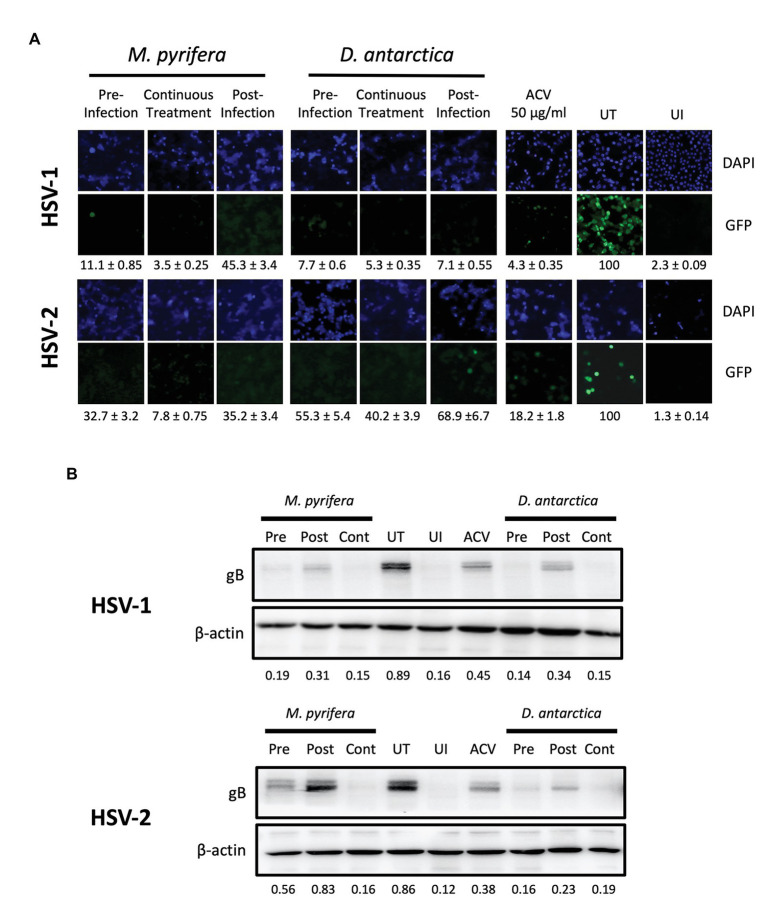
Antiviral activity of the M. pyrifera and D. antarctica algae aqueous extracts added at different time-points relative to HSV infection to HeLa cells. The algae extracts were added at 1 mg/ml to HeLa cells at different time-points relative to infection. The treatments with the algae extracts were added either, 1 h previous to infection and then removed after infection (Pre-infection), added 1 h after infection and left for a total of 6 h (Post-infection), or added in a continuous manner, that is, 1 h before infection and then after infection for 6 h (continuous treatment). Cells were infected with HSV at an MOI 1. (A) Representative images of GFP-derived fluorescence (green) in cells treated either, with the M. pyrifera or D. antarctica extracts and infected with a GFP-encoding HSV-1 (upper panels) or GFP-encoding HSV-2 (lower panels). Cell nuclei were counterstained with DAPI (blue). GFP-derived fluorescence was quantified using ImageJ software. (B) Western blot analyses for the viral protein gB and host protein beta-actin (loading control) 24 hpi with HSV-1 (upper panels) or HSV-2 (lower panels). Representative images are shown for the western blots. The quantifications correspond to the means of three independent experiments. The GFP fluorescence and the intensity of the bands in the western blots were quantified using ImageJ software. UI, uninfected; UT, untreated; ACV, acyclovir.